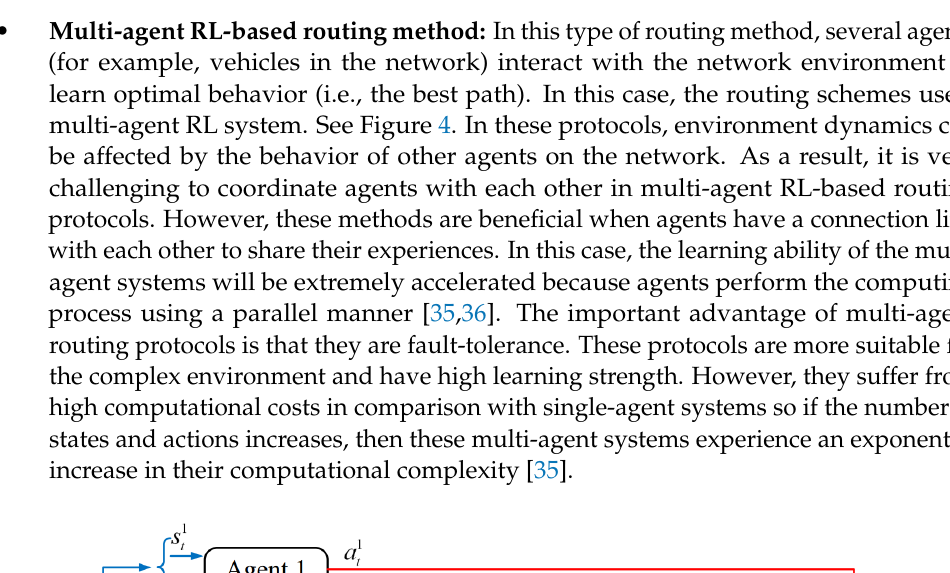
Figure 3. A single-agent system.